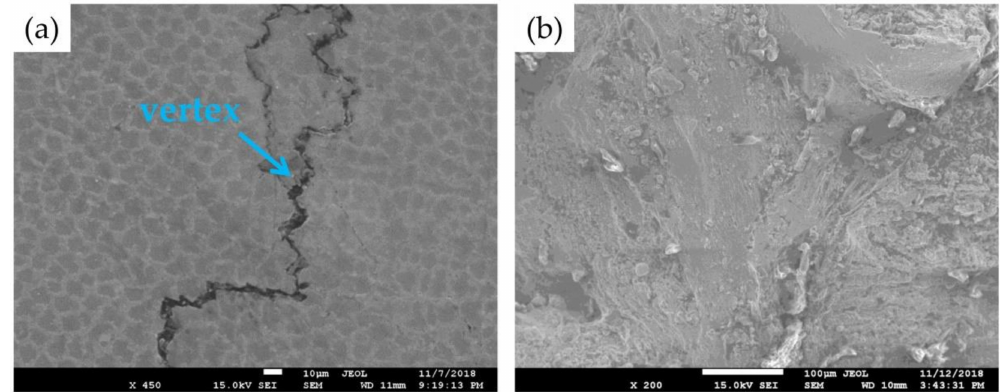
Figure 12. Morphology of ( a ) a ductility dip crack and ( b ) its section.